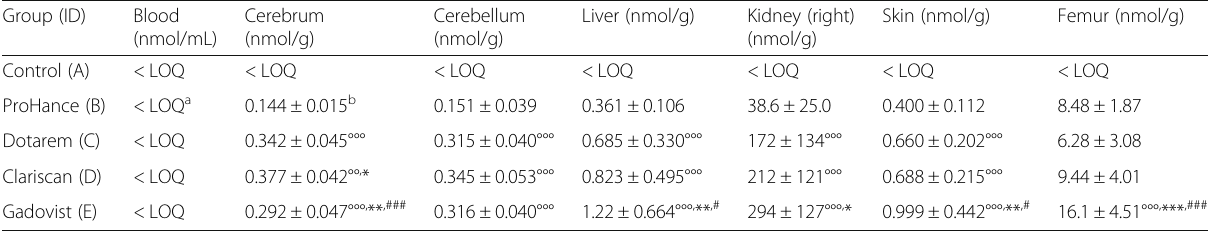
Table 1 Gadolinium content in the blood, cerebrum, cerebellum, liver, kidney, skin, and femur (mean values ± SD)